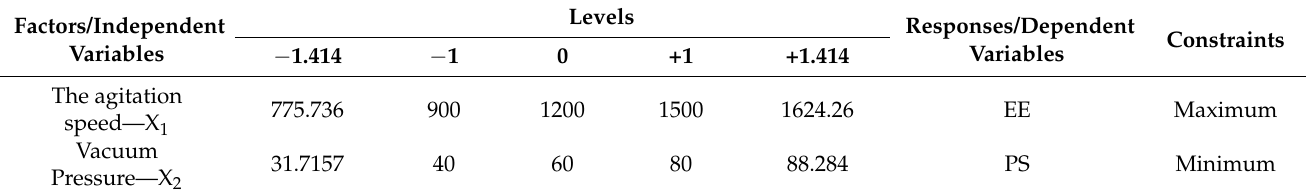
Table 1. Experimental plan for CCD in terms of actual and coded